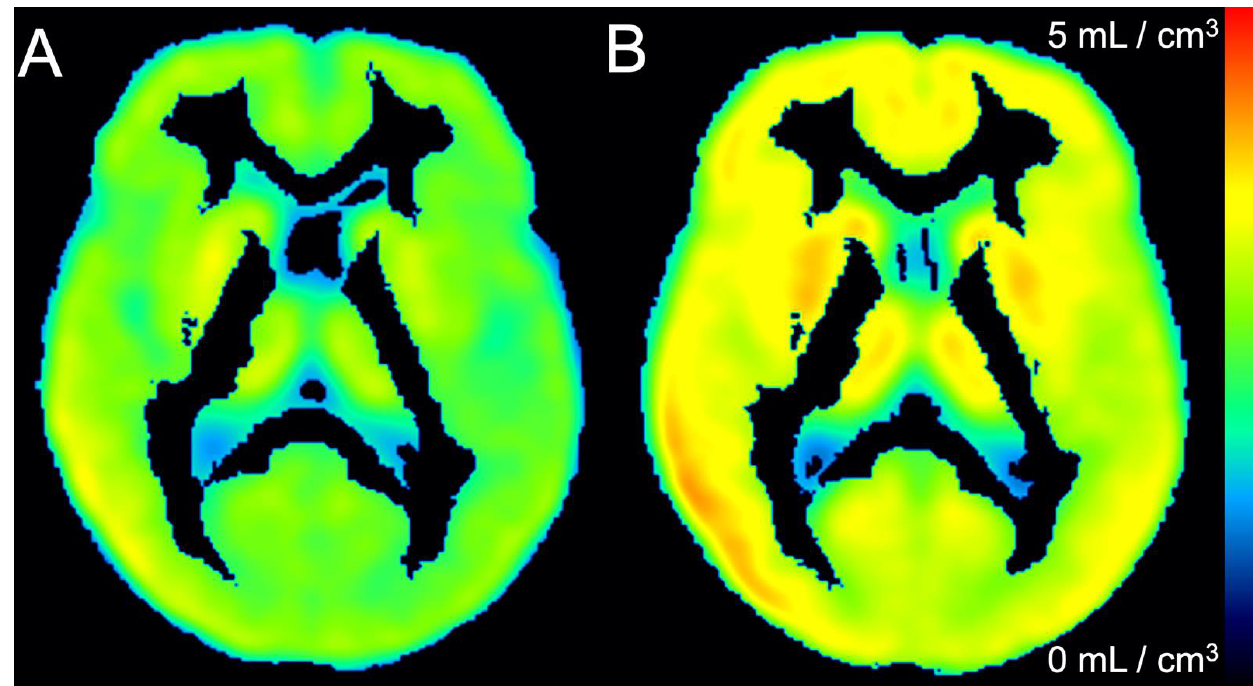
Figure 5. Mean one tissue compartment V T parameter maps of ( A ) healthy controls and ( B ) Parkin- son’s disease patients.